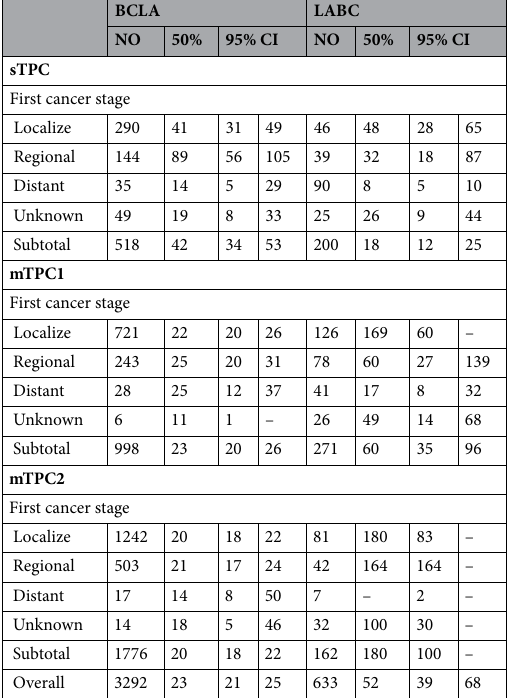
Table 4. Overall-survival analysis since secondary diagnosis in patients with BCLA/LABC. Group sTPC, mTPC1 and mTPC2 were categorized by first cancer stage; Overall survival was determined by median survival time (month). – not